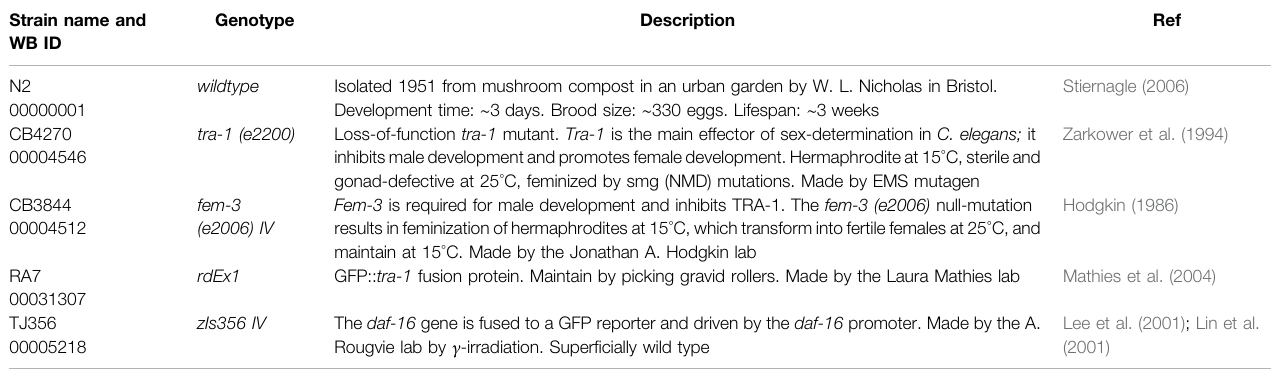
TABLE 1 | Characterization of C. elegans wild-type and mutant strains. Strain name and WB ID